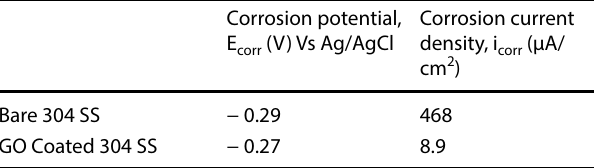
Table 2 Polarization scan parameters